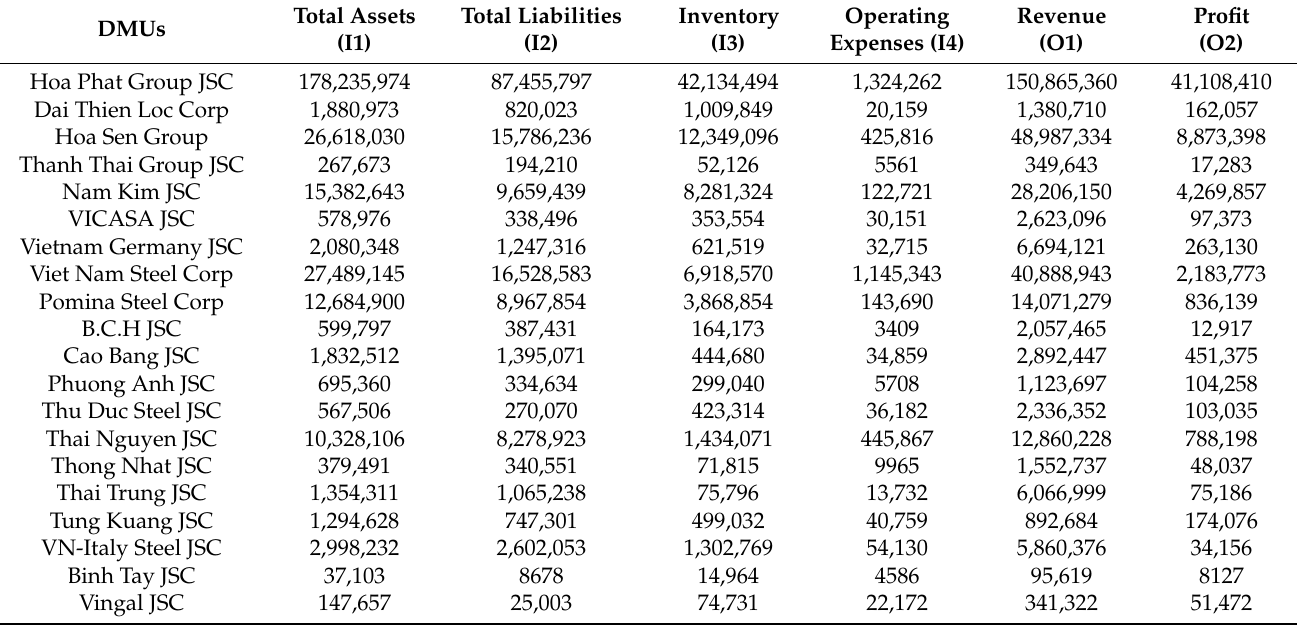
Table 5. The dataset of 20 suppliers for the Vietnamese steel